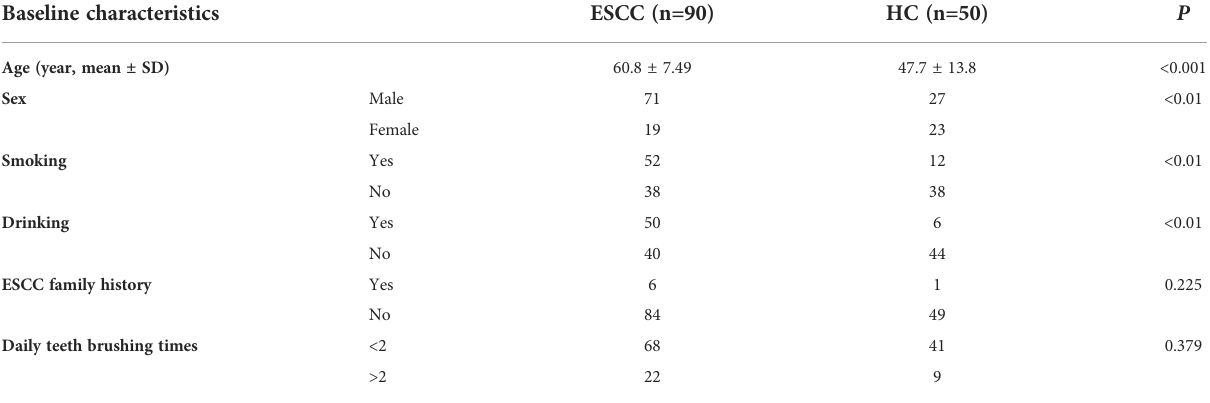
TABLE 1 Clinical information of patients in the ESCC and healthy control (HC) groups. Baseline